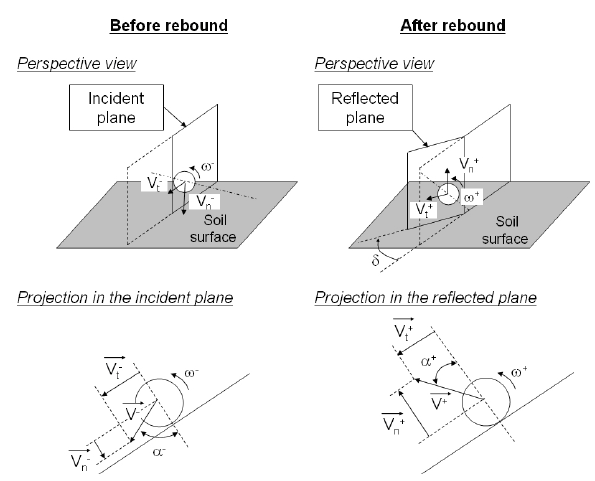
Fig. 6. Definition of the block velocity before and after rebound.